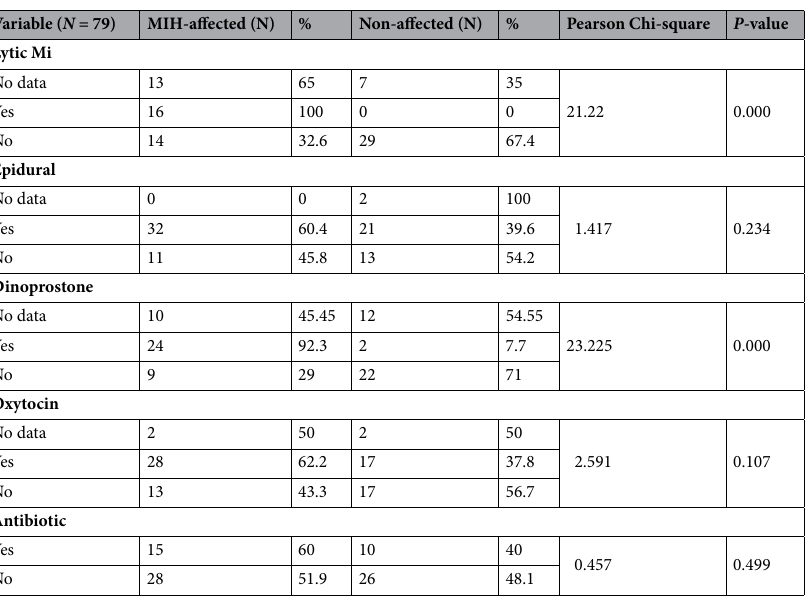
Table 1. Medicines administered to the mother during